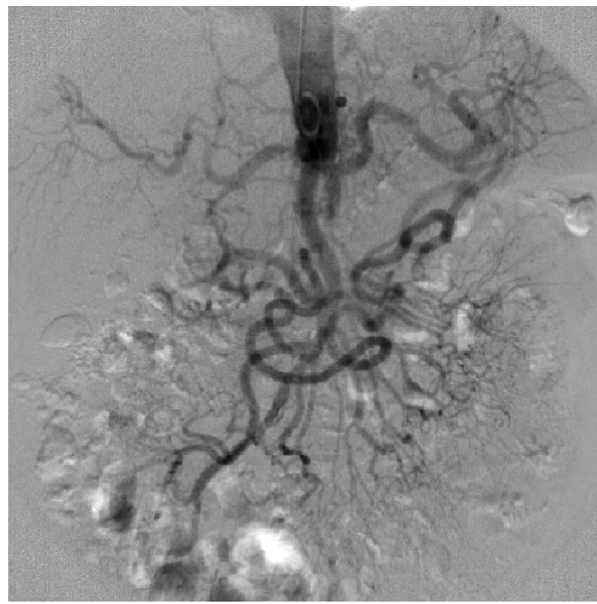
Figure 3 - An AP view of the abdominal aorta by aortography. The distal portion of the a. mesenterica superior (SMA) is completely occluded. The proximal of the SMA, the coeliac truncus and its branches can be seen